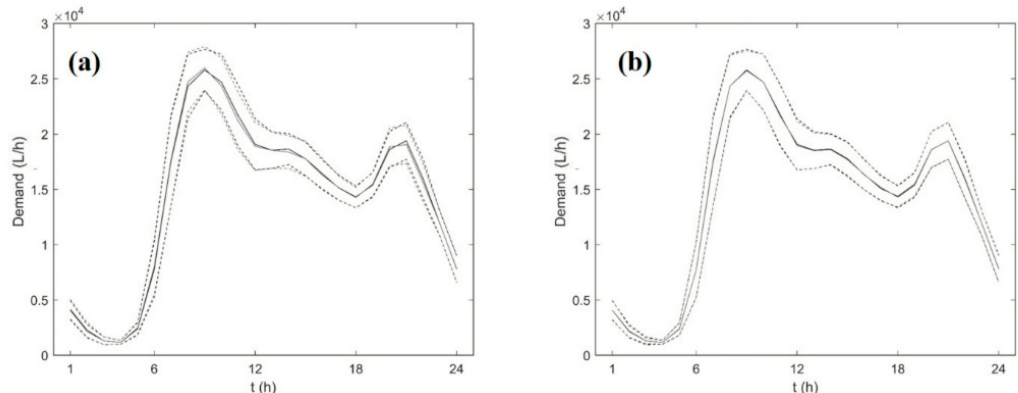
Figure 6. Case study 2 (Application 2) - Daily temporal patterns of both mean µ (continuous lines) and intervals µ ± 0.5 σ (dotted lines) for measured (black lines) and generated (grey lines) aggregated demands: the generated demands were obtained applying the top-down approach ( a ) and the bottom-up approach ( b ) respectively.